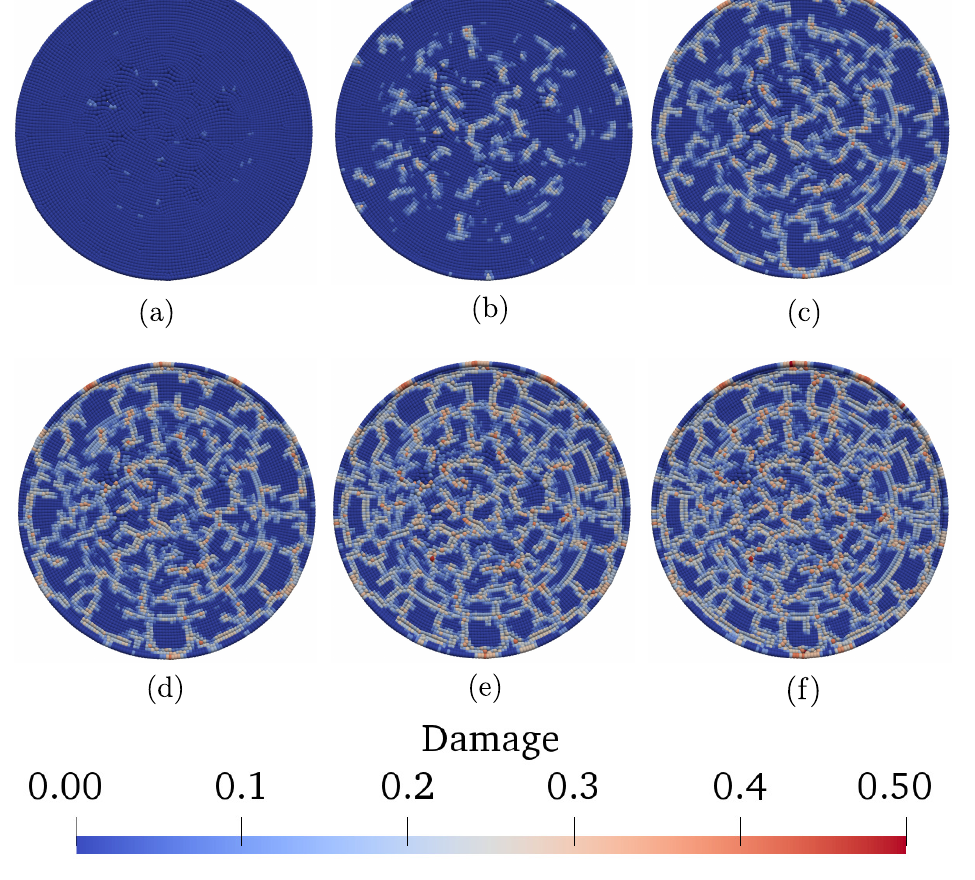
Figure 7. Snapshots of the contours of damage in the soil sample at 6 load steps ( a ) Step 25; ( b ) Step 50; ( c ) Step 75; ( d ) Step 100; ( e ) Step 150; ( f ) Step 200, for δ = 2.2 mm. Note: The deformation is amplified by a factor of 5 for